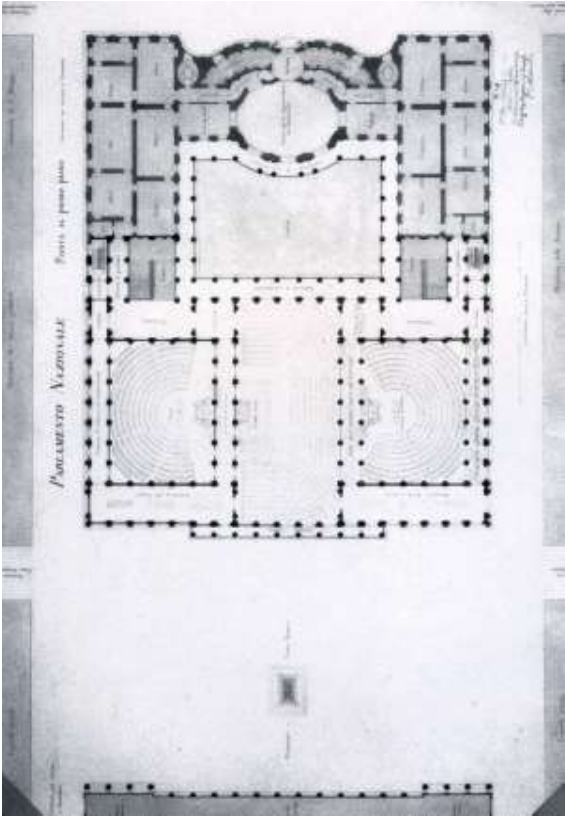
Figure 2. Alessandro Antonelli, National Parliament, first floor,